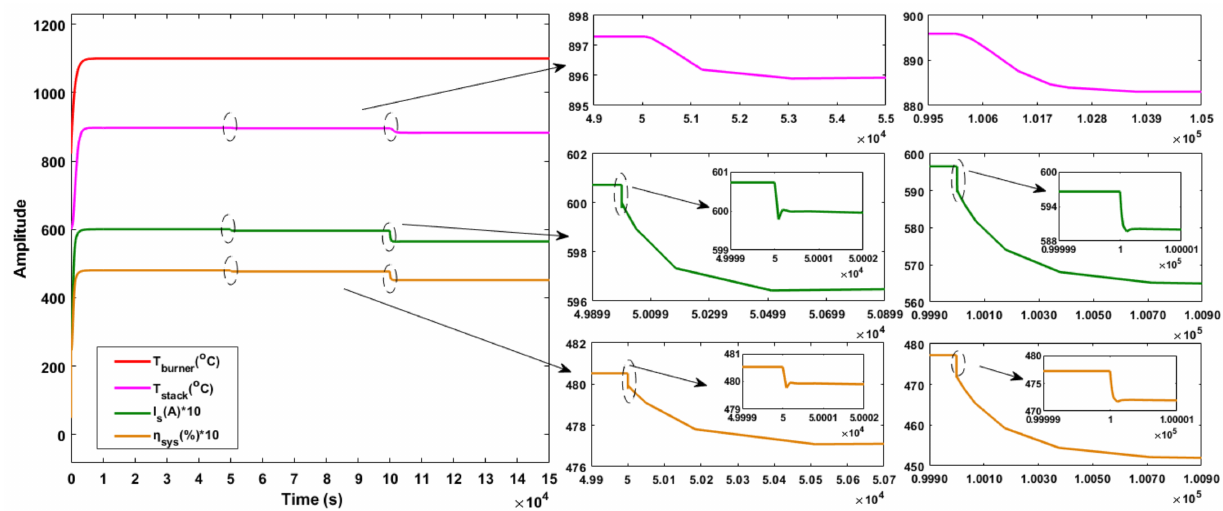
Figure 9. The performance curve of system mode change is caused by the heat exchanger